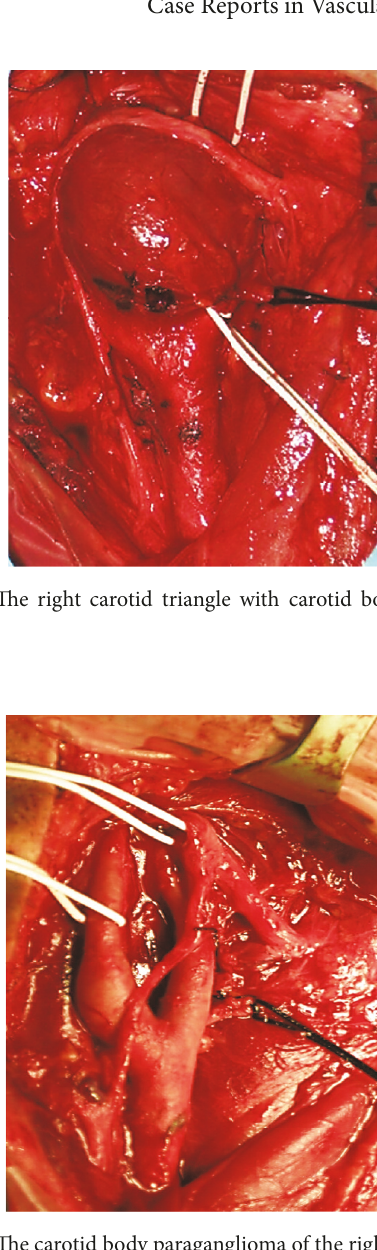
Figure 10: The carotid body paraganglioma of the right carotid tri- angle was completely excised, with preservation of the hypoglossal and vagus